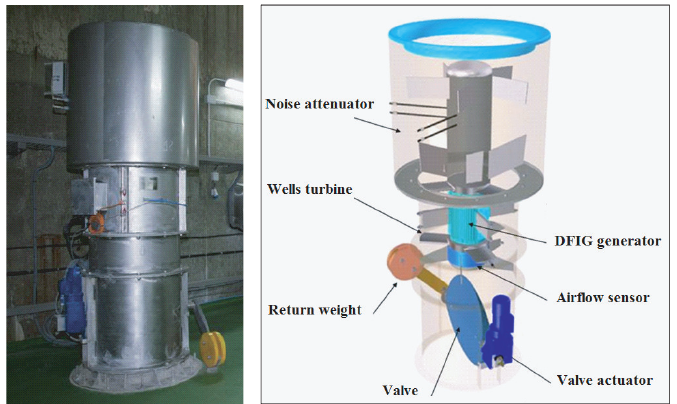
Figure 2. Wells turbine and DFIG-based of OWC system